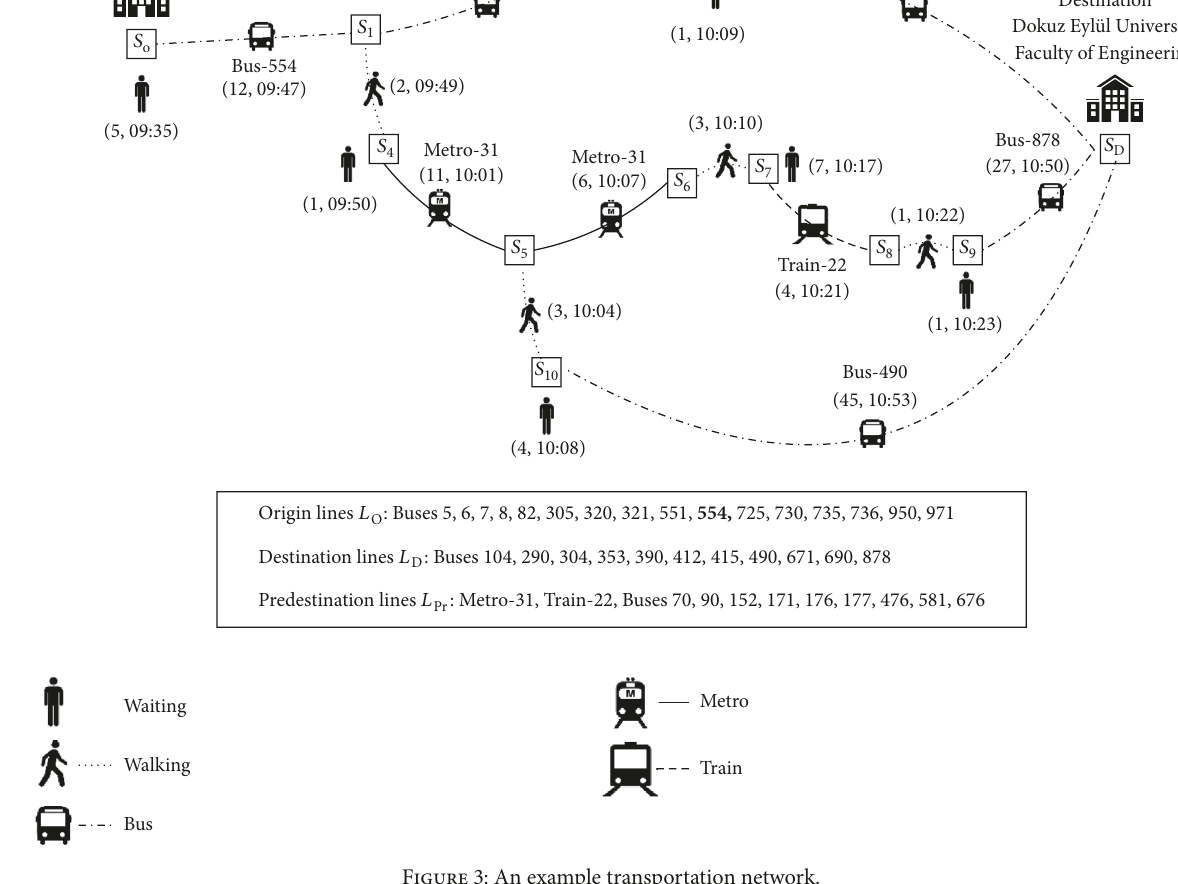
Figure 3: An example transportation network.